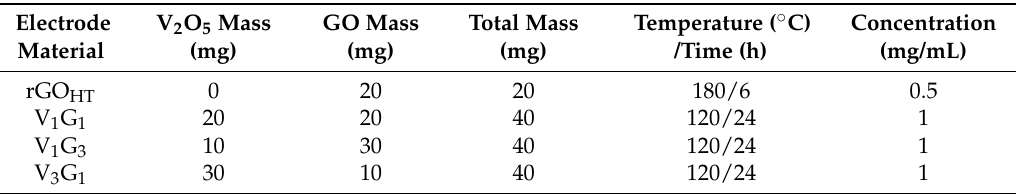
Table 1. Deposition parameters for the hydrothermal process. rGO HT , hydrothermally-processed reduced graphene oxide.